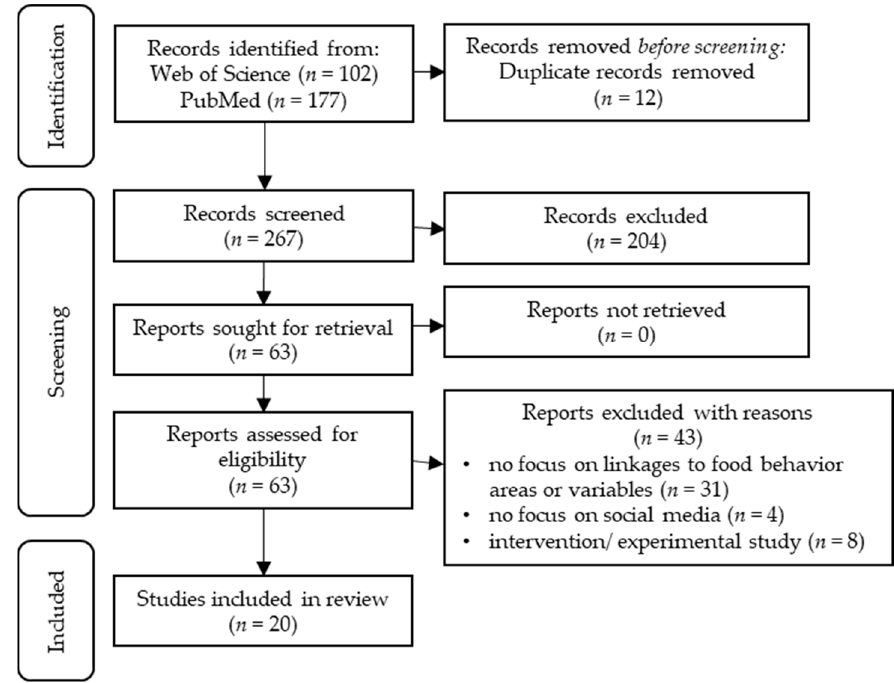
Figure 1. Flow diagram of the article selection process.